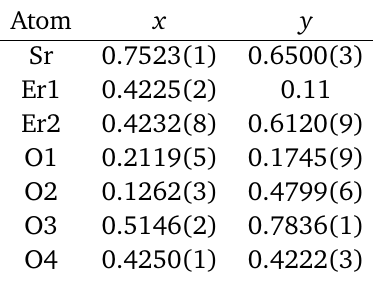
Table AI: Refined ionic positions of SrEr data measured at 20 K. The dimensions of the orthorhombic ( Pnam ) unit cell are a = 10.0189 Å, b = 11.8611 ( 9 ) Å and c = 3.3893 Å. All the ions occupy the 4 c Wyck- off sites with general positions ( x , y ,0.25 ) .